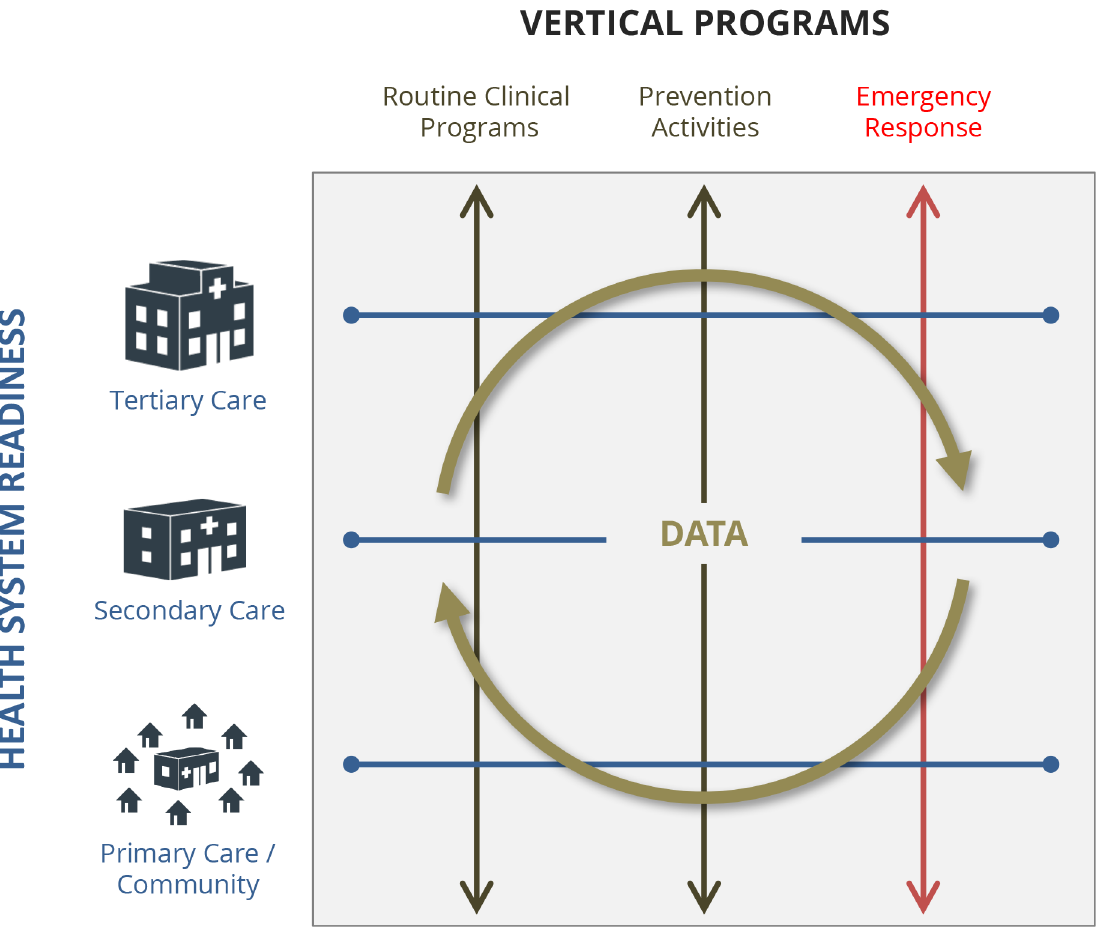
Fig 2. Strengthened health systemsare grounded in three components: (1) horizontal readiness includessupply chain management, adequate and well-trainedstaff, medicines,and infrastructure that must be availableat all levels of care—primary care through basic health centers and community health programs, secondary hospital care (district hospitals), and tertiary care in nationalreferral and universityhospitals;(2) vertically integrated programs includeroutine clinical programssuch as maternal- child health and infectiousdiseasemanagement, preventionactivitiessuch as vaccine campaigns,and emergency response to plagueand other outbreaks; (3) integrateddata from health management information systems and epidemiologicalsurveillance.